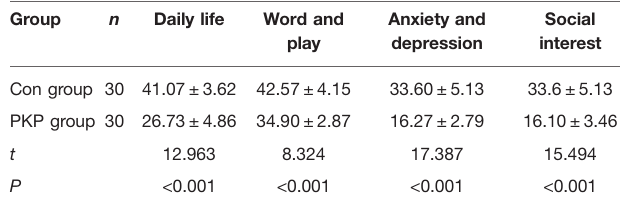
TABLE 2 | Comparison of Dallas pain questionnaire at 6 months post- treatment between two groups. Group n Daily life